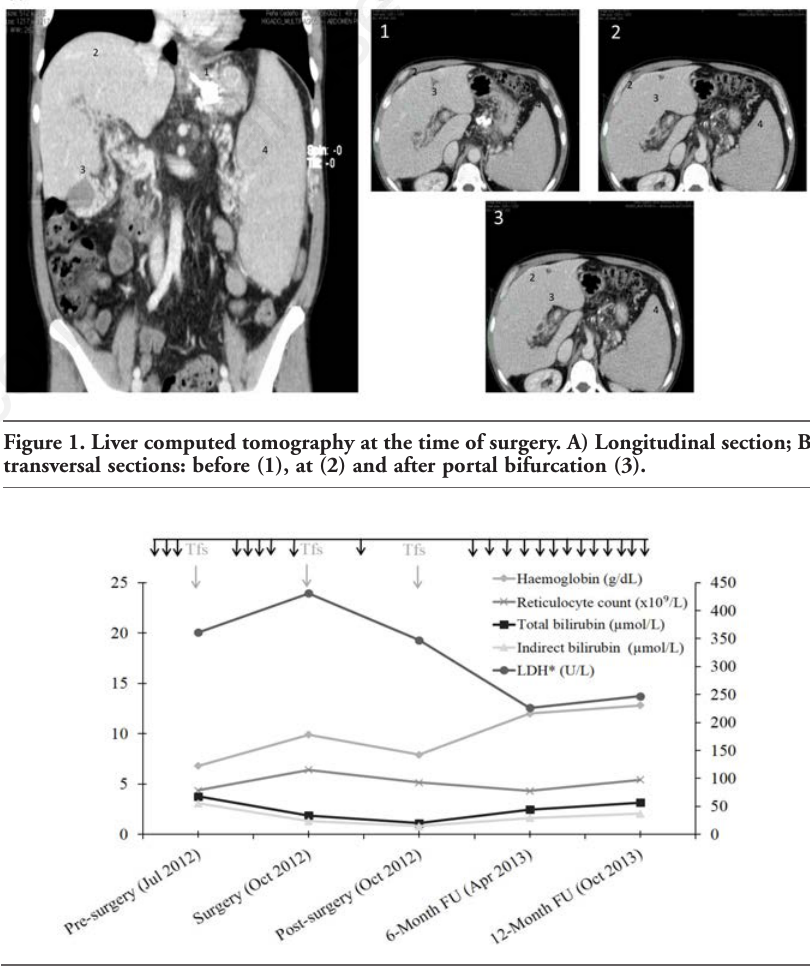
Figure 2. Changes in hematological parameters over time. Individual points represent single measurements in the patient. *LDH activity (U/L) shown on right-hand axis; black arrows indicate eculizumab treatment; FU, follow-up; Tfs,